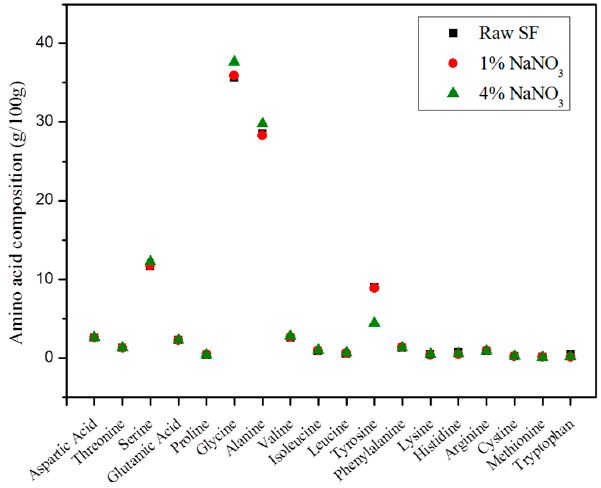
Figure 5. Amino acid composition of SF gel depending on the NaNO 3 concentration.